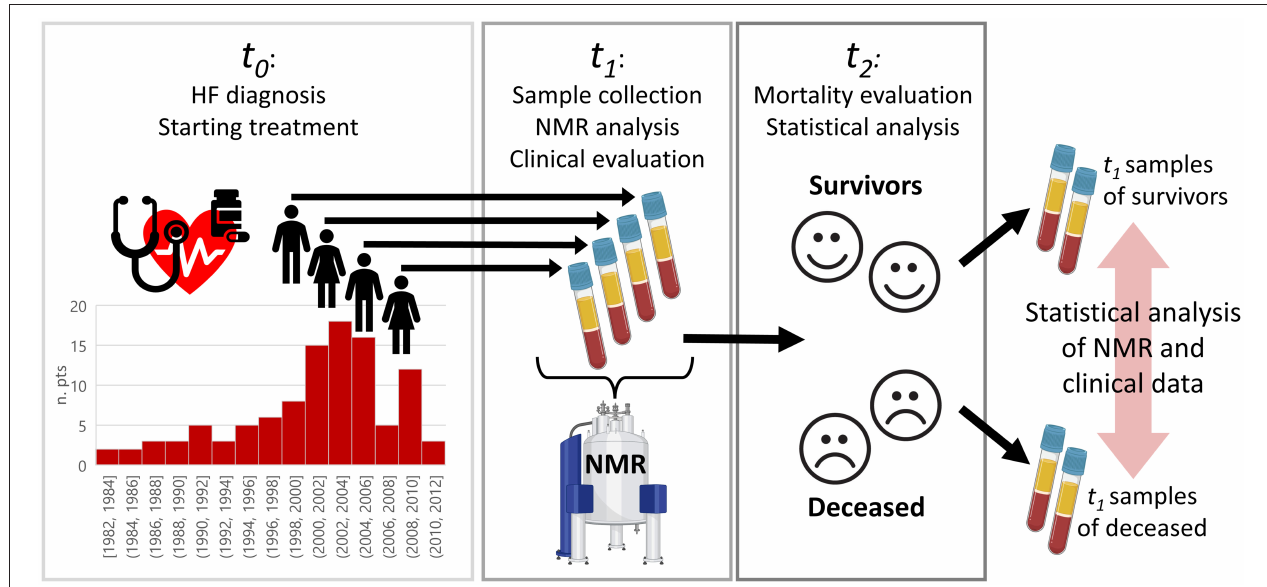
FIGURE 1 | Graphical overview of the study design to investigate differences between survived and deceased patients with HF. Patients were diagnosed at time t0, where t0 for each patient was in the range 1982–2011. Between 2010 and 2012 (t1), the patients were re-examined or examined for the first time, blood serum samples collected and analyzed via nuclear magnetic resonance (NMR). Survival status was evaluated in 2019 (t2). Patients were, then, retrospectively split in two groups according to the survival status (alive vs. deceased), and statistical analysis on NMR data was